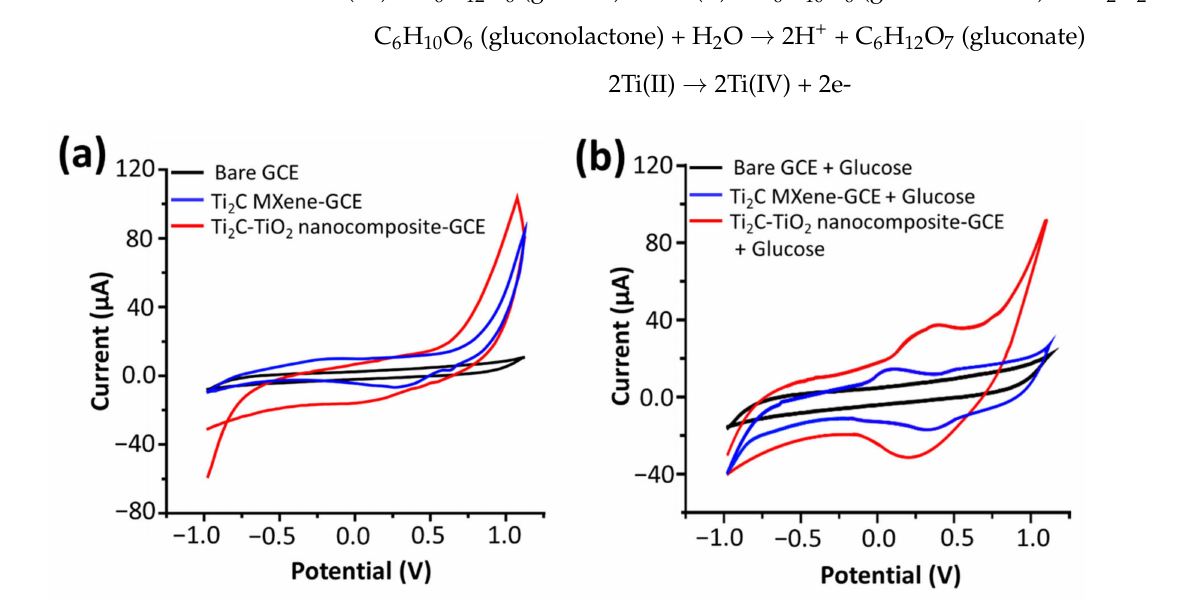
Figure 3. Cyclic voltammogram (CV) of bare, and modified GCE (with Ti 2 C MXene and Ti 2 C-TiO 2 MXene nanocomposite), ( a ) without, and ( b ) with 0.1 mM glucose, recorded in 0.1 M NaOH (pH 13) at 100 mV s − 1